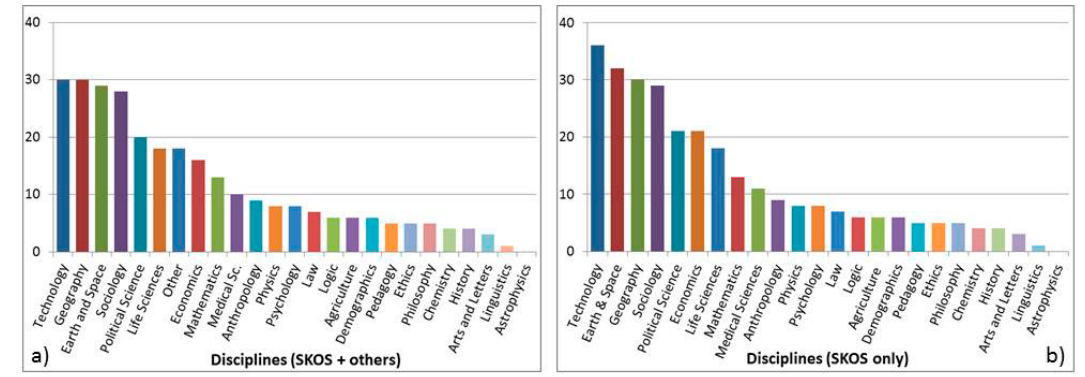
fig. 4. no. of projects involving a discipline as answered by respondents (a) and as after a redistribution of the category “other” (b)